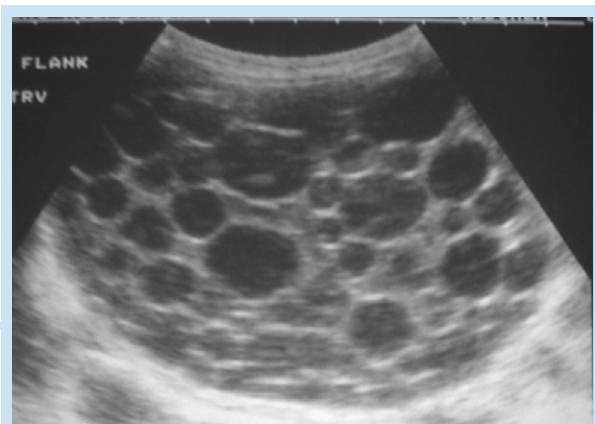
Fig. 1. Longitudinal ultrasound of right upper quadrant showing the hydatid cyst with multiple small daughter cysts.